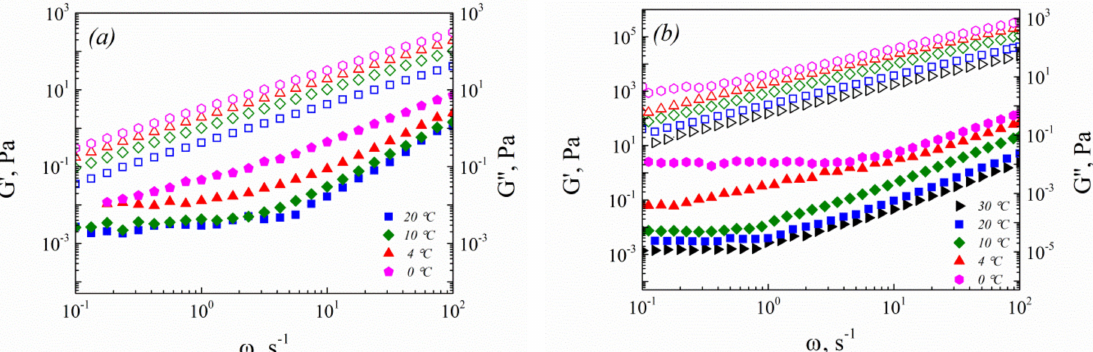
Figure 10. Frequency dependences of the storage modulus G (cid:48) (filled symbols) and loss modulus G” (open symbols) obtained for w/o emulsions with aqueous phase content of 1% ( a ) and 30% ( b ). γ = 0.1%. Temperatures are shown on